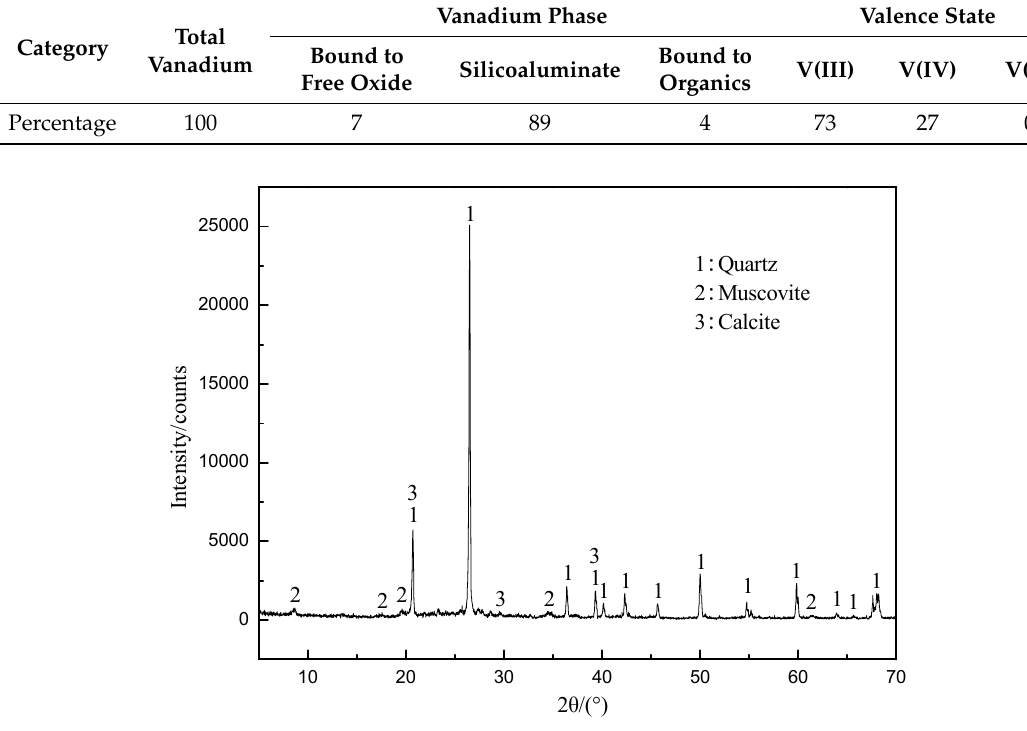
Table 3. Vanadium phase analyses and its valence state in raw ore wt %.